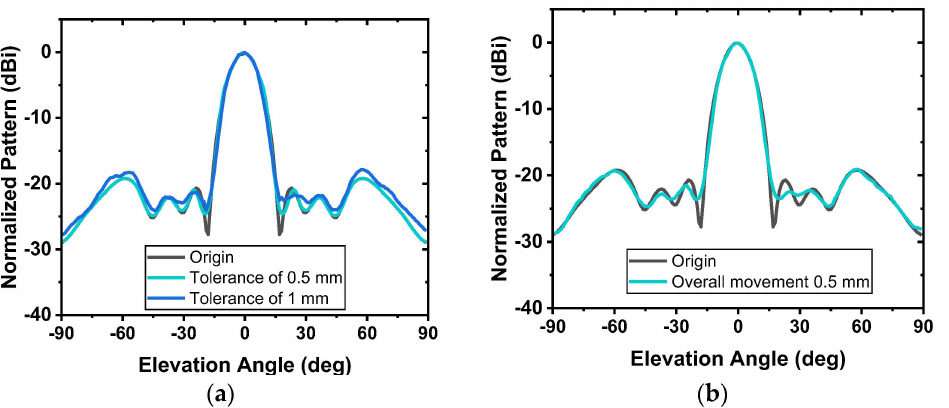
Figure 13. Normalized radiation patterns. ( a ) Sparse array synthesized by MCDE and array with different tolerances. ( b ) Normalized radiation patterns of the original sparse array and array with the overall movement of 0.5